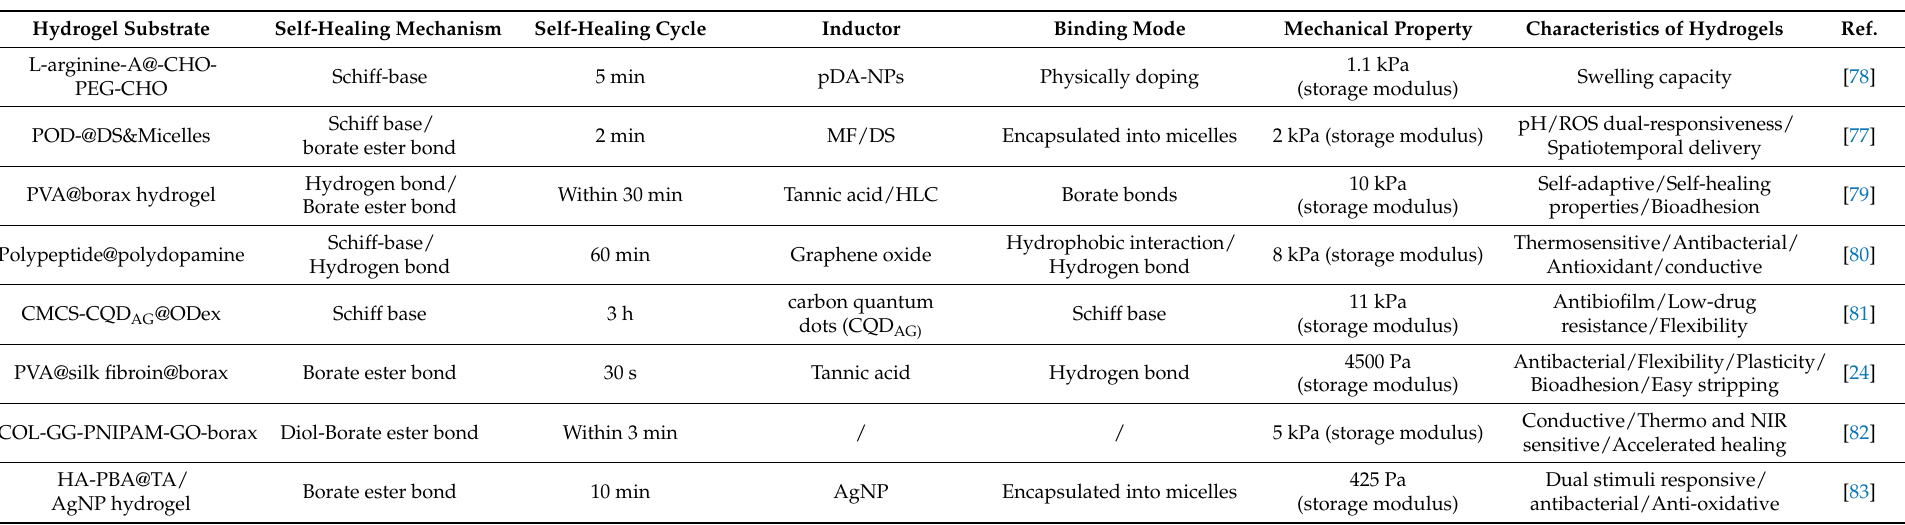
Table 3. Self-healing hydrogel for skin